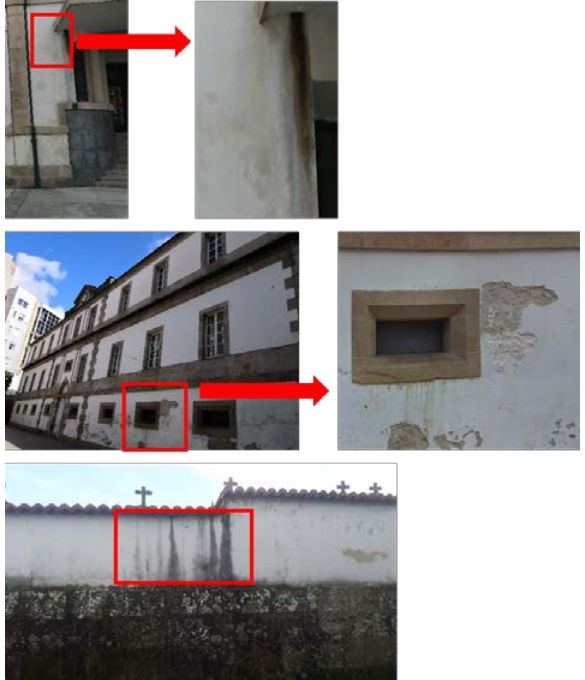
Figure 2. Visible images of the case studies (regions of interest in red rectangles). Reference name, from top to bottom: Test_1, Test_2 and